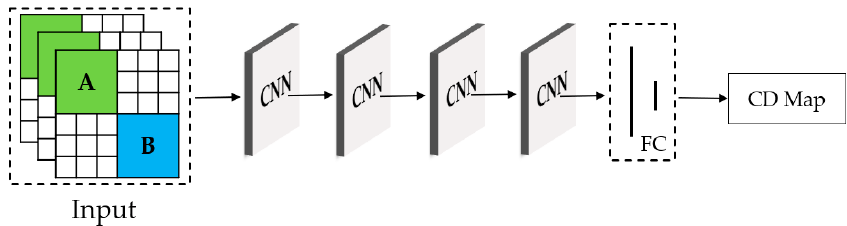
Figure 4. Diagram of the network frame .